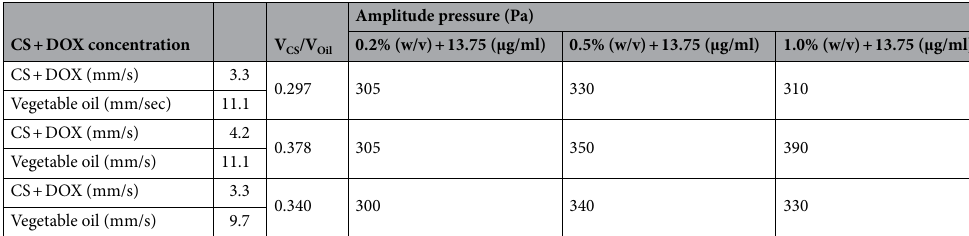
Table 3. The amplitude of pressure